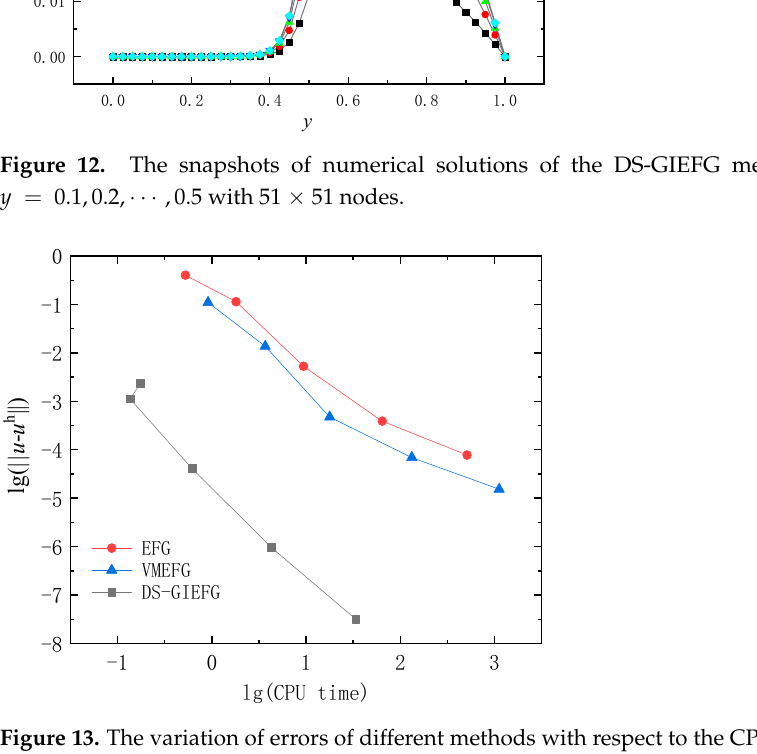
Figure 13. The variation of errors of different methods with respect to the CPU time (in lg–lg scale).